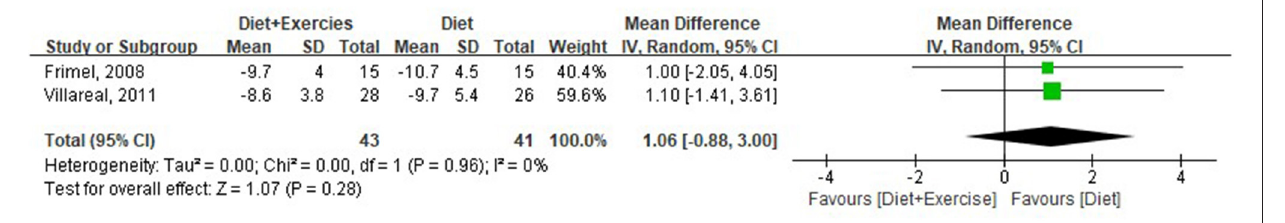
Frontiers in Nutrition |